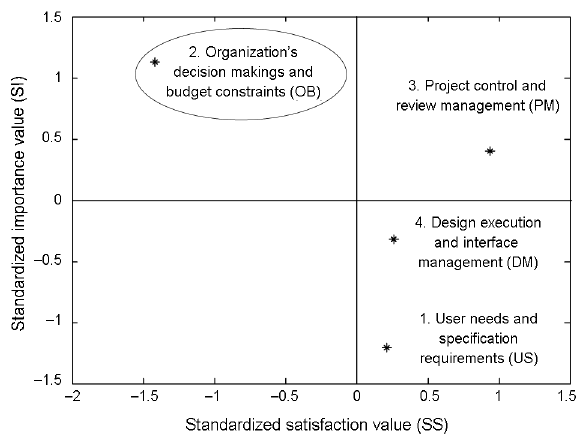
Fig. 3. ISA analysis of first-level factors